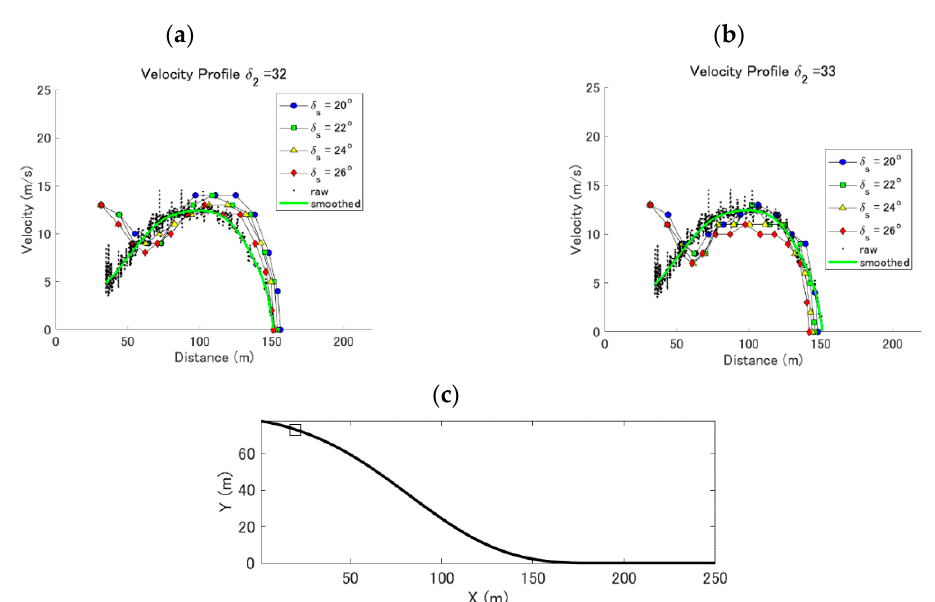
Figure 10. Comparison of the flow front velocity in the case of a particle diameter d = 3.8 cm. ( a ) Simulations with δ 2 = 32°. ( b ) Simulations with δ 2 = 33°. In each graph, the simulation results of δ s = 20° (blue circle), δ s = 22° (green square), δ s = 24° (yellow triangle), and δ s = 26° (red diamond). Ping-pong ball experimental results of raw (black dots) and smoothed data (green line) are included. ( c ) The slope profile used to simulate the ping-pong ball simulations. A square in the slope figure shows the position of the ping-pong ball container. Raw and smoothed data of front velocity are from